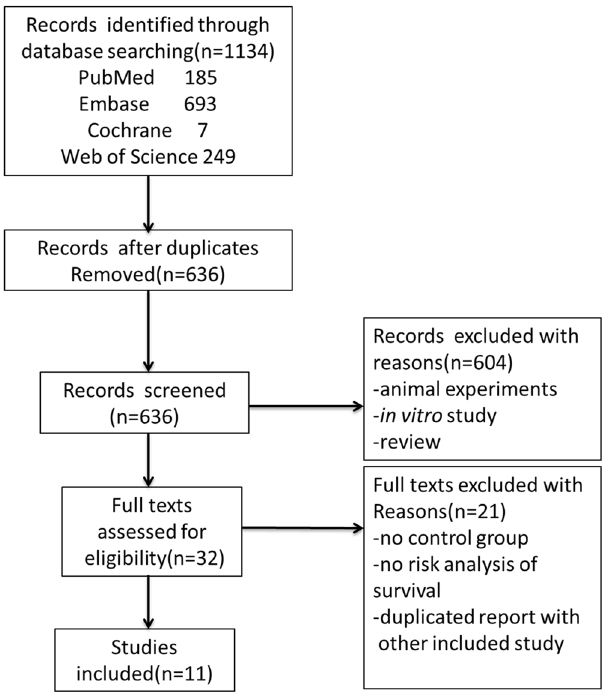
Figure 1. PRISMA flowchart summarizing the study identification and